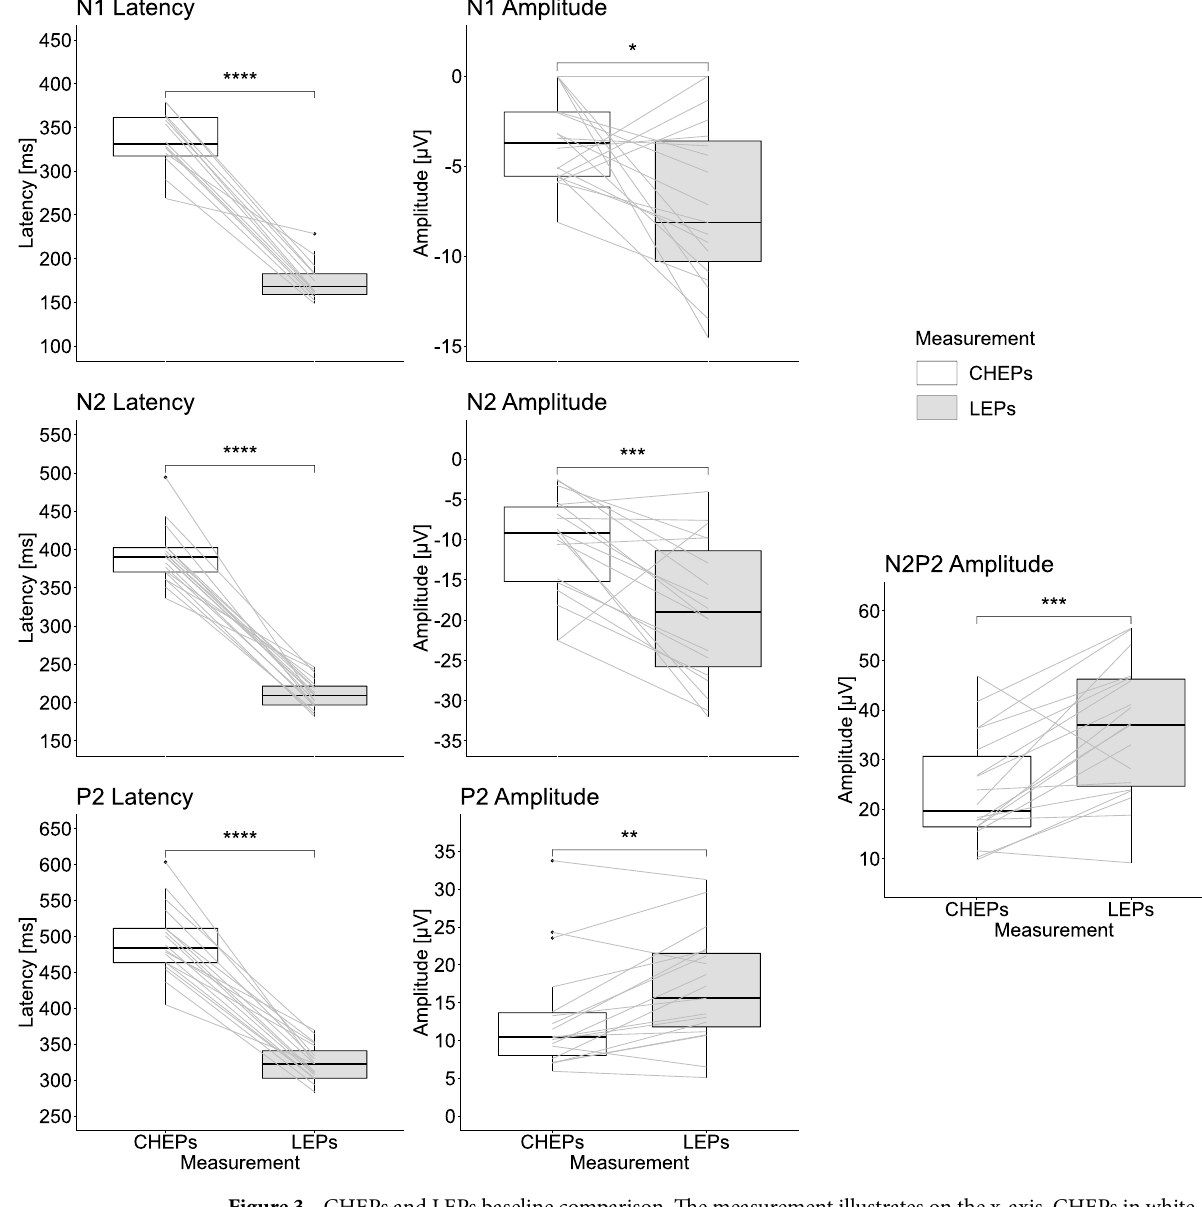
Figure 3. CHEPs and LEPs baseline comparison. The measurement illustrates on the x-axis, CHEPs in white and LEPs in gray. The y-axis illustrates the LEPs and CHEPs parameters (latency or amplitude). Subjects’ responses of both methods are connected by a grey line.